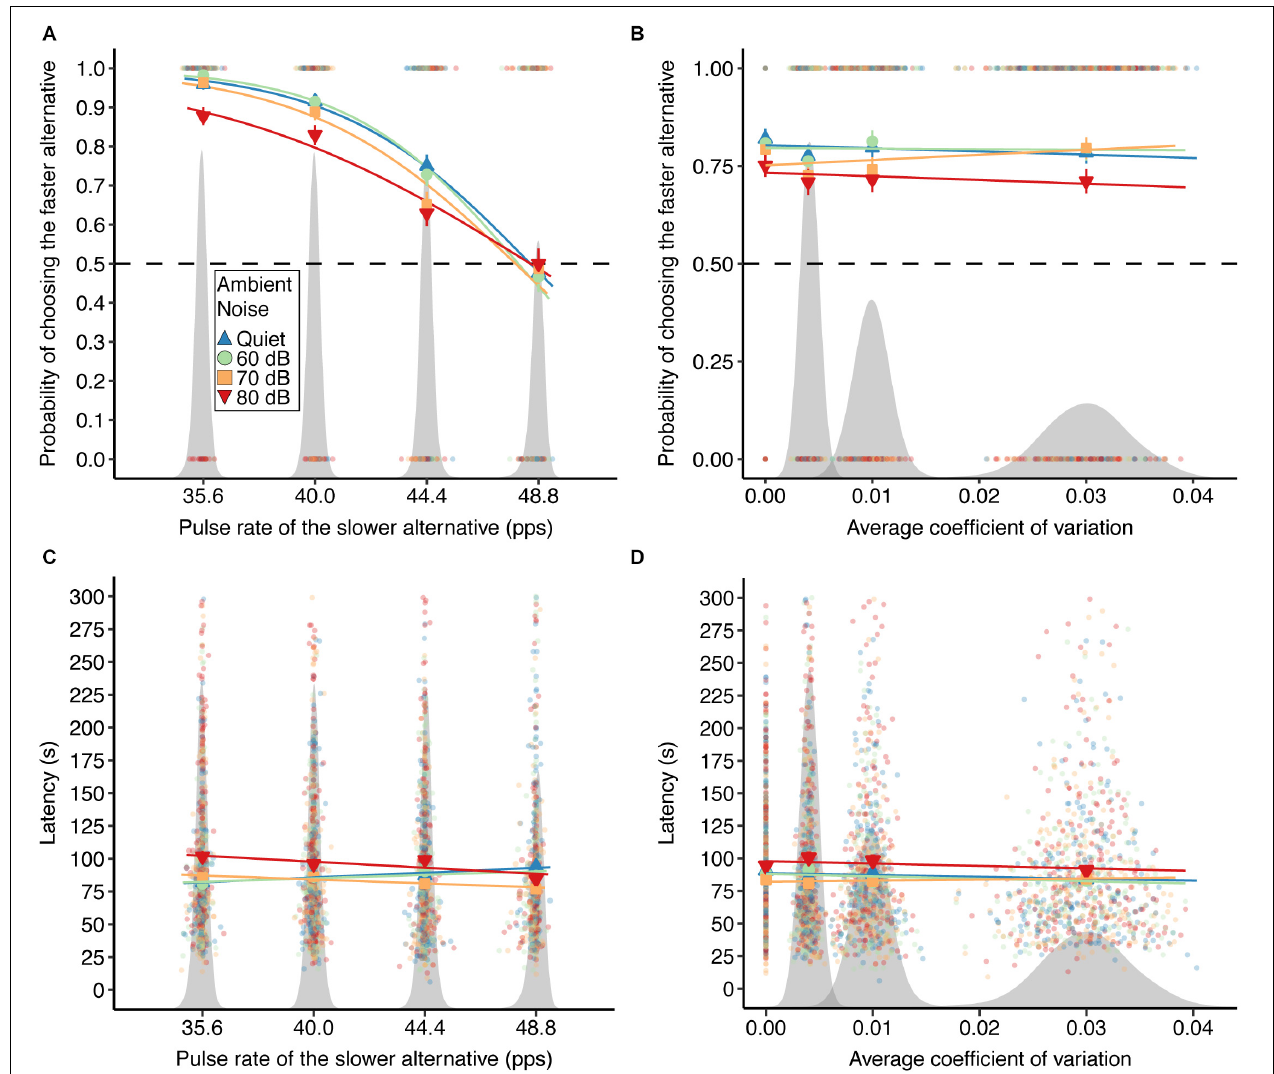
FIGURE 3 | The effects of pulse rate, ambient noise, and inconsistency on receiver responses. (A) The probability of choosing the preferred, faster pulse rate declined as a function of the realized pulse rate of the slower alternative. (B) The probability of choosing the faster stimulus was not affected by the average CV w of the two alternative stimuli. In panels (A,B) , the dashed black line shows 0.5, the probability of choosing the stimulus with the faster pulse rate at random. Response latency as a function of (C) the realized pulse rate of the slower alternative and (D) the average coefficient of variation within males. In all panels, the results of individual tests are shown with pale, circular symbols. Colors and symbols shown in the legend depict mean response variables within combinations of predictors, while lines show linear model fits and error bars show standard errors. Different colors and symbols represent levels of ambient noise. Gray shading shows the distributions of experimental stimuli for each plot: realized mean alternative pulse rates are shown in panels (A,C) , and average realized coefficients of variation are shown in panels (B,D)